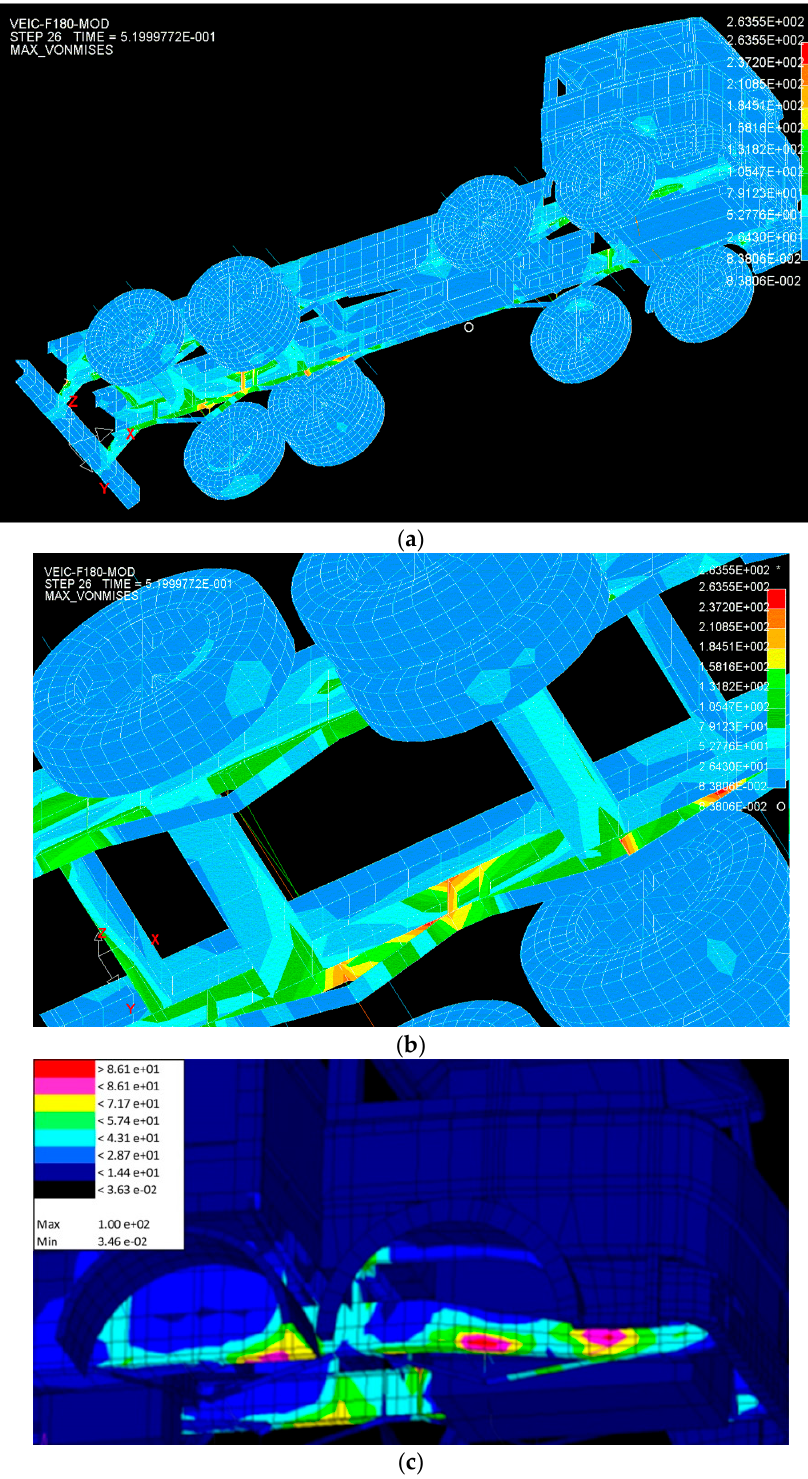
Figure 21. Heavy vehicle stress (MPa) at 90 km/h: ( a ) full vehicle, ( b ) magnification of medium and rear axles and ( c ) magnification of front axles.